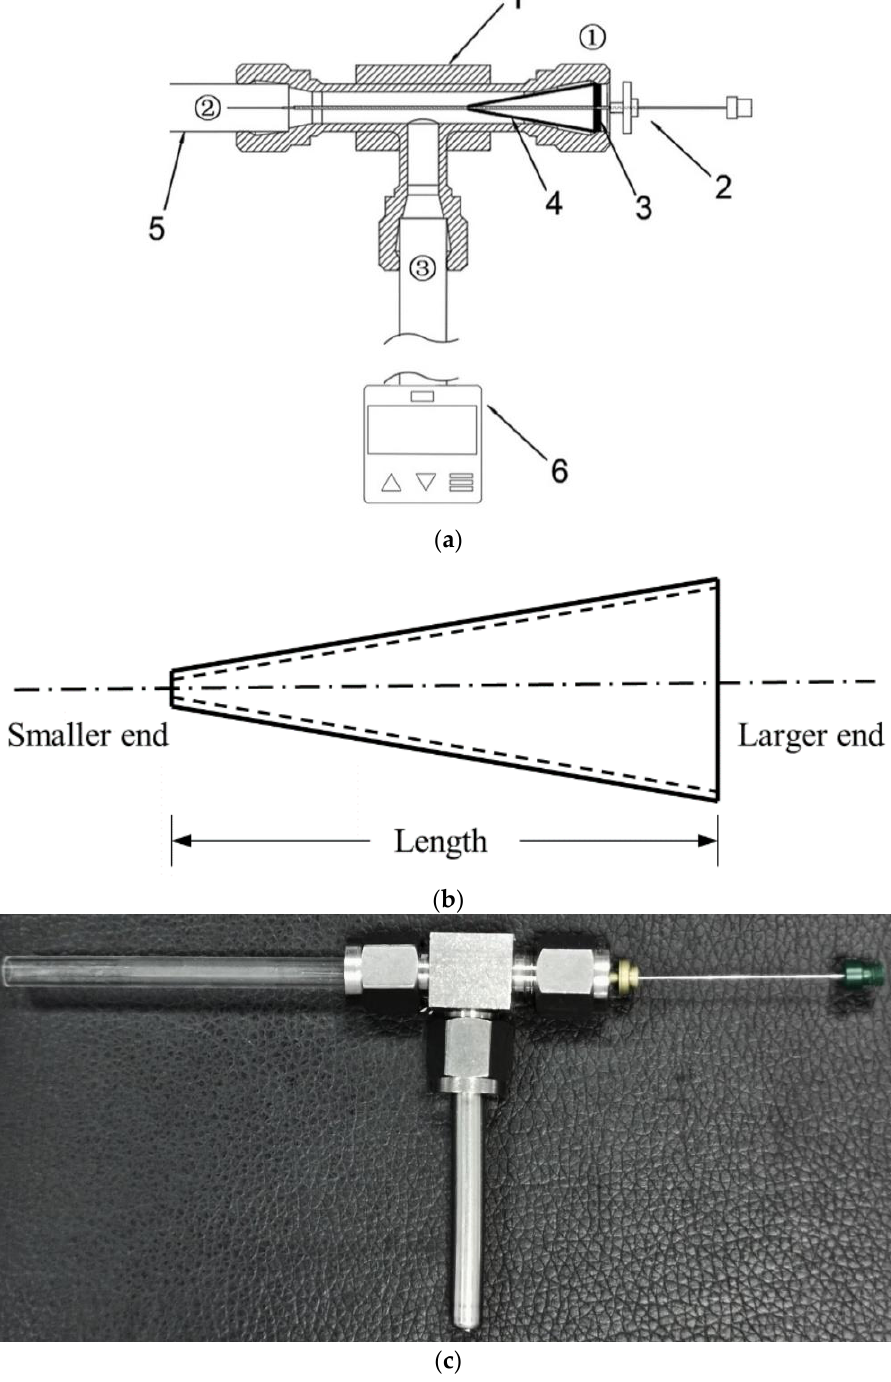
Figure 1. ( a ) Schematic of the SPME-based active sampler designed in this study. ( b ) Schematic of the truncated cone tube in the SPME-based active sampler and ( c ) photo. 1, two-ferrule tee connector; 2, SPME; 3, sealing gasket; 4, truncated cone; 5, sampling tube; and 6, sampling pump. ① , ② , and ③ correspond to openings 1, 2, and 3, respectively.